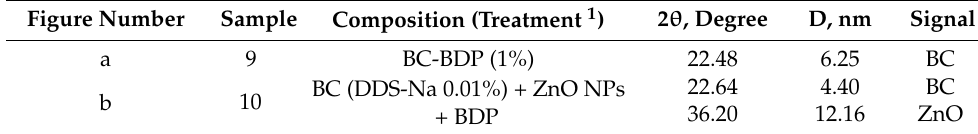
Figure 4. Powder XRD patterns of BC compositions: ( a ). BC-BDP (1%); ( b ). BC (DDS-Na 0.01%) + ZnO NPs+ BDP. Table 5. Data of Powder XRD patterns of BC-ZnO NPs samples (Figure 4). Figure Number